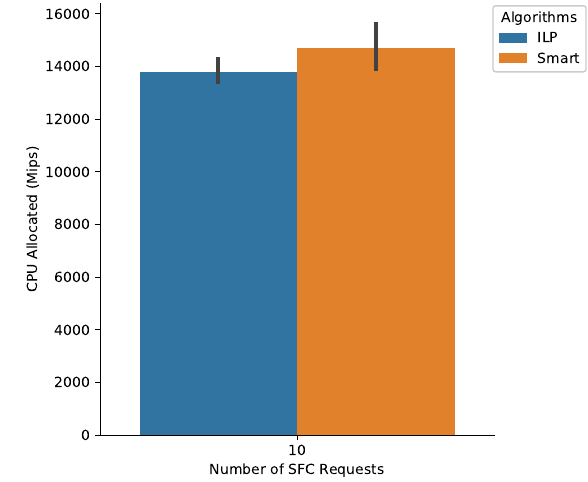
Figure 5. Allocated CPU Resources.